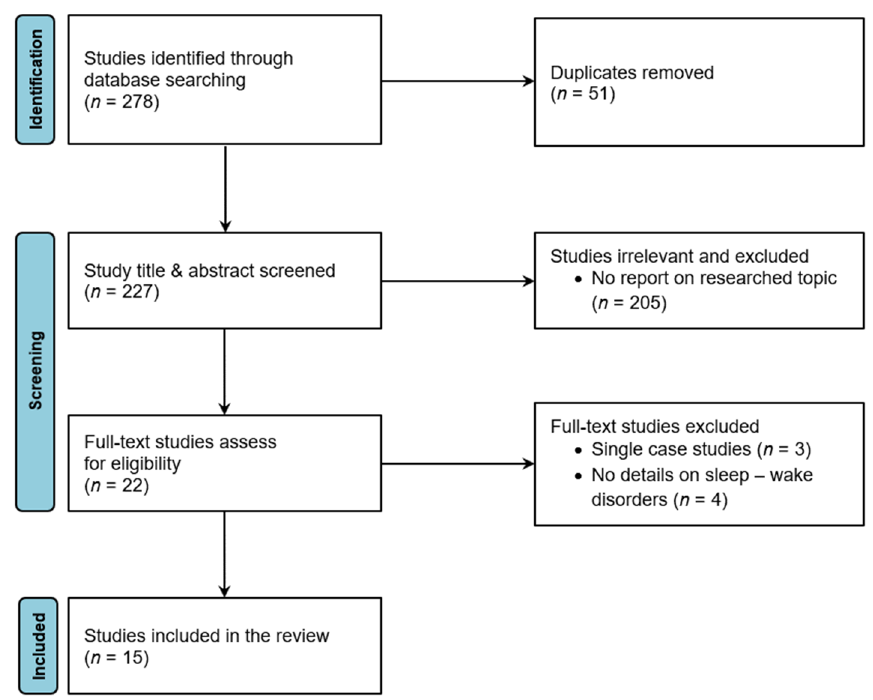
Figure 1. Flowchart describing search and selection strategy. Two hundred seventy-eight references were identified through the search.